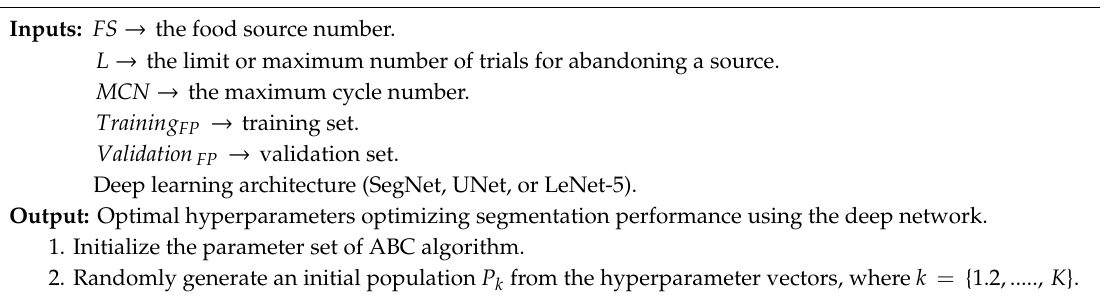
Algorithm 2: The ABC algorithm for selecting the optimal hyperparameter values that optimize the performance of segmentation using the deep network. Inputs: FS → the food source number. MCN → the maximum cycle